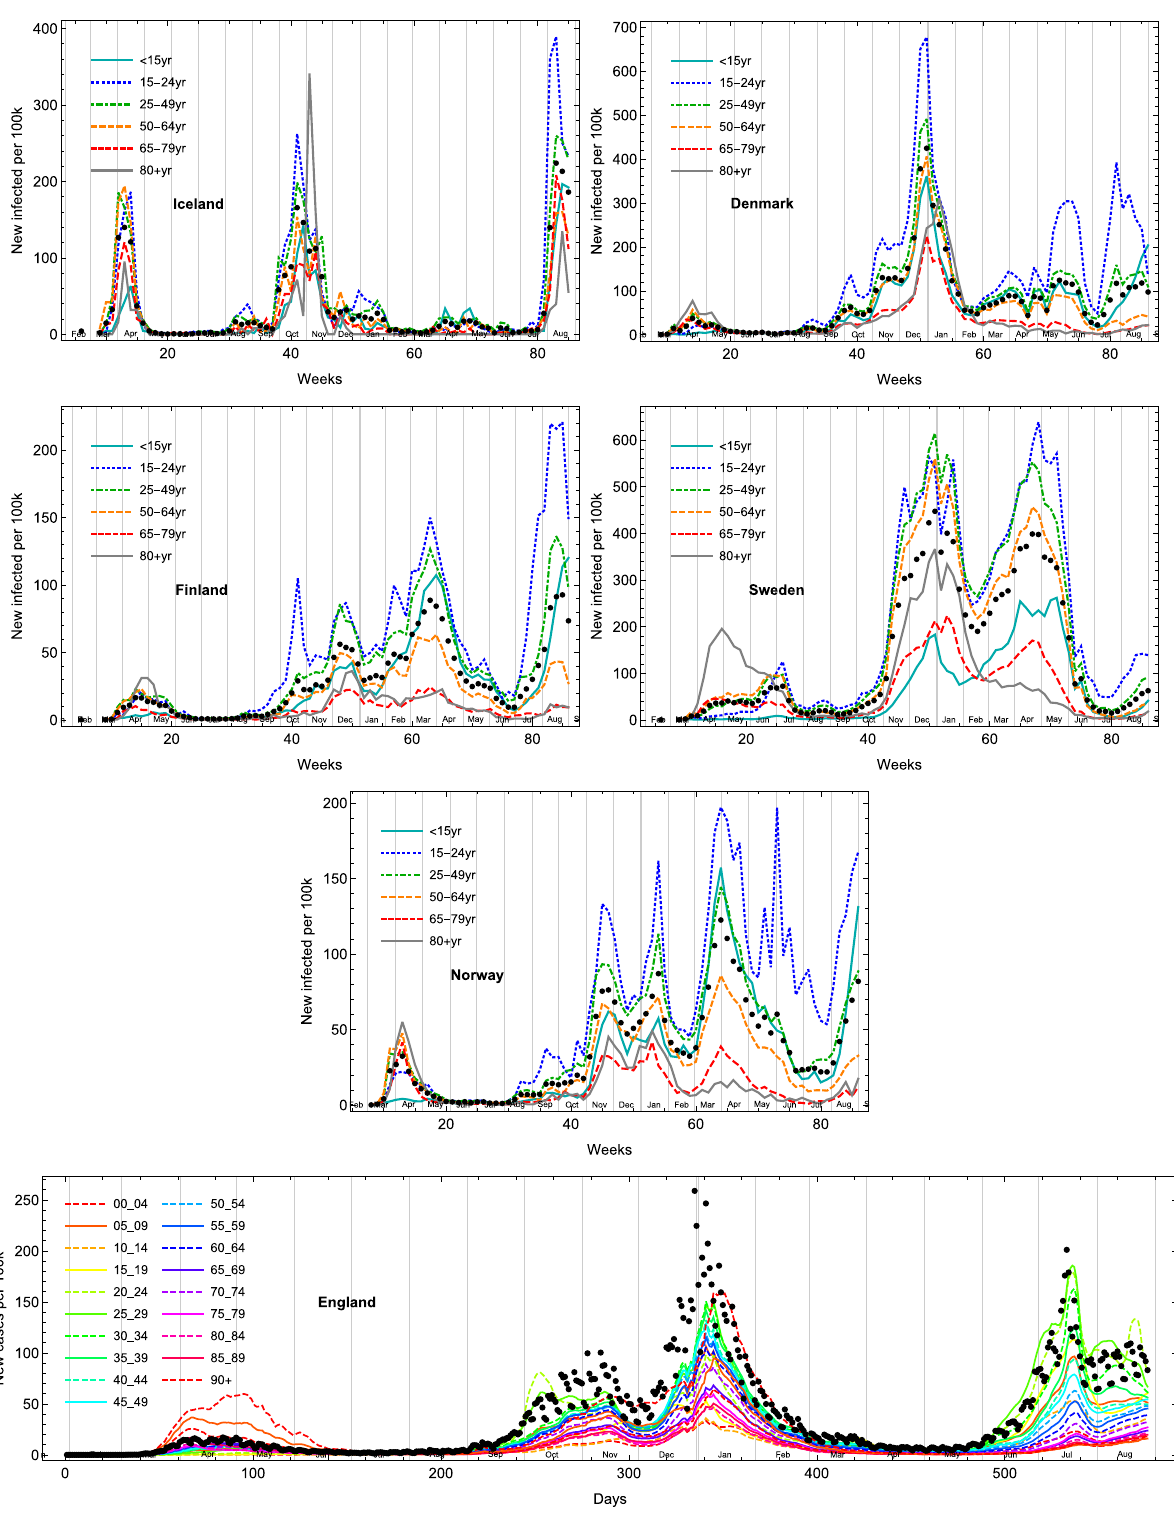
Figure 8. Number of cases per 100k inhabitants from each age class within Iceland, Denmark, Finland, Sweden, Norway and England. Black dots represents the number of new cases per 100k inhabitants for all age